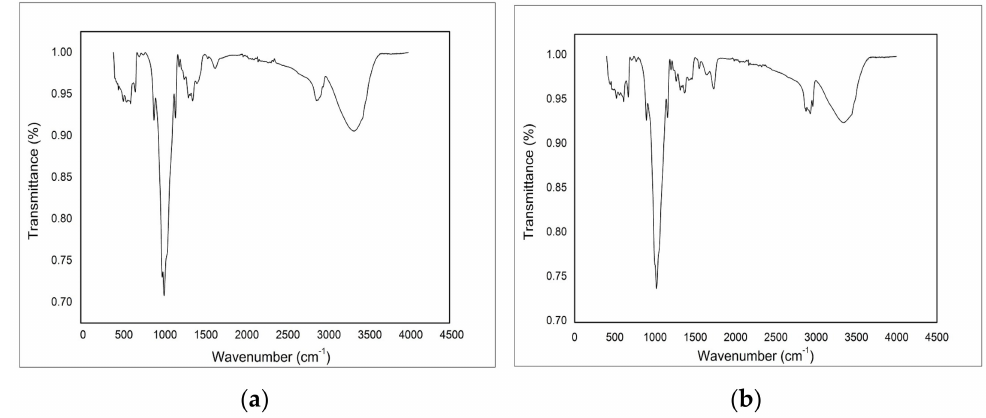
Figure 4. FTIR spectra of ( a ) V-DEHPA-Fe and ( b ) VF-DEHPA-Fe. Additionally, vibrations specific to P–OH bonds at 2340 and 1654 cm − 1 were observed.